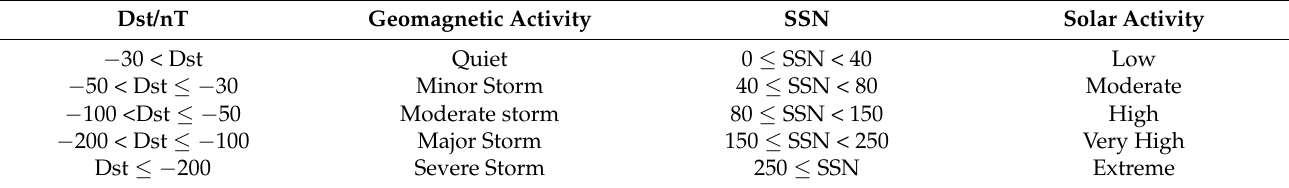
Table 1. Classification of geomagnetic activity and solar